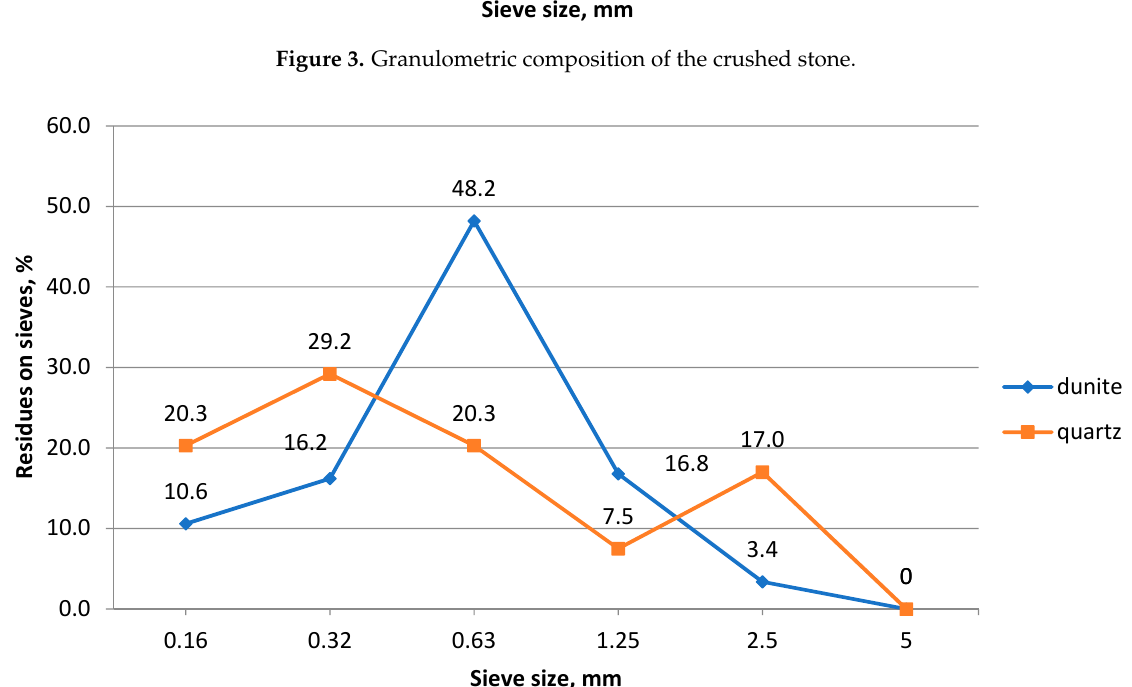
Figure 4. Granulometric composition of the sand.